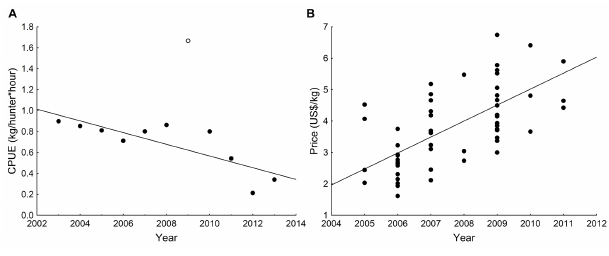
Fig. 6 . (A) Negative trend of tortoise hunting productivity (catch per unit effort) over the years of monitoring, considering both upland and whitewater flooded forests. (B) Increasing trend of the price per kilogram of tortoises sold by hunters of the studied reserves to the urban